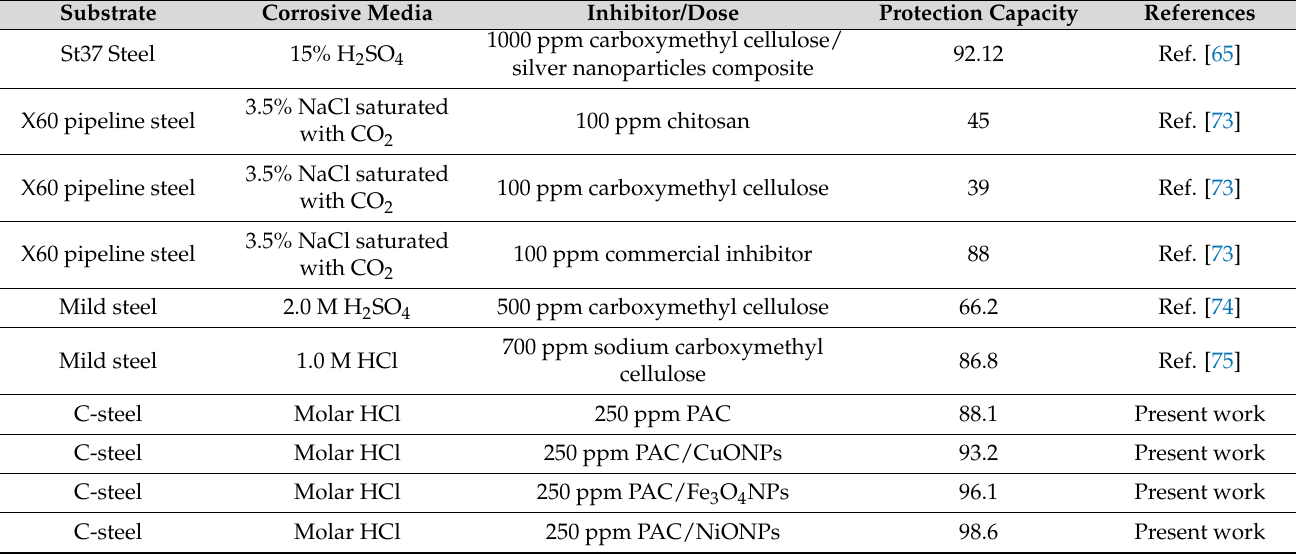
Table 4. Comparison of the protection capacity of synthesized nanocomposites with existing